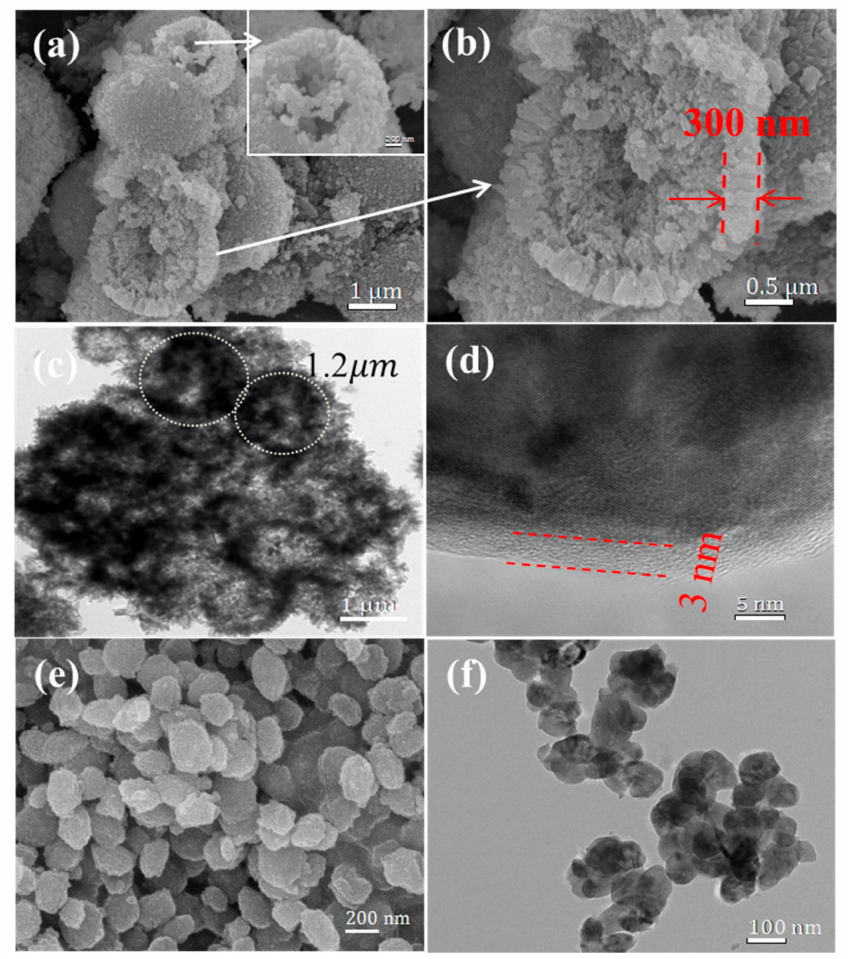
Figure 2. ( a , b ) SEM images of LFP-A; ( c , d ) TEM images of LFP-A; and ( e ) SEM and ( f ) TEM images of LFP-B.